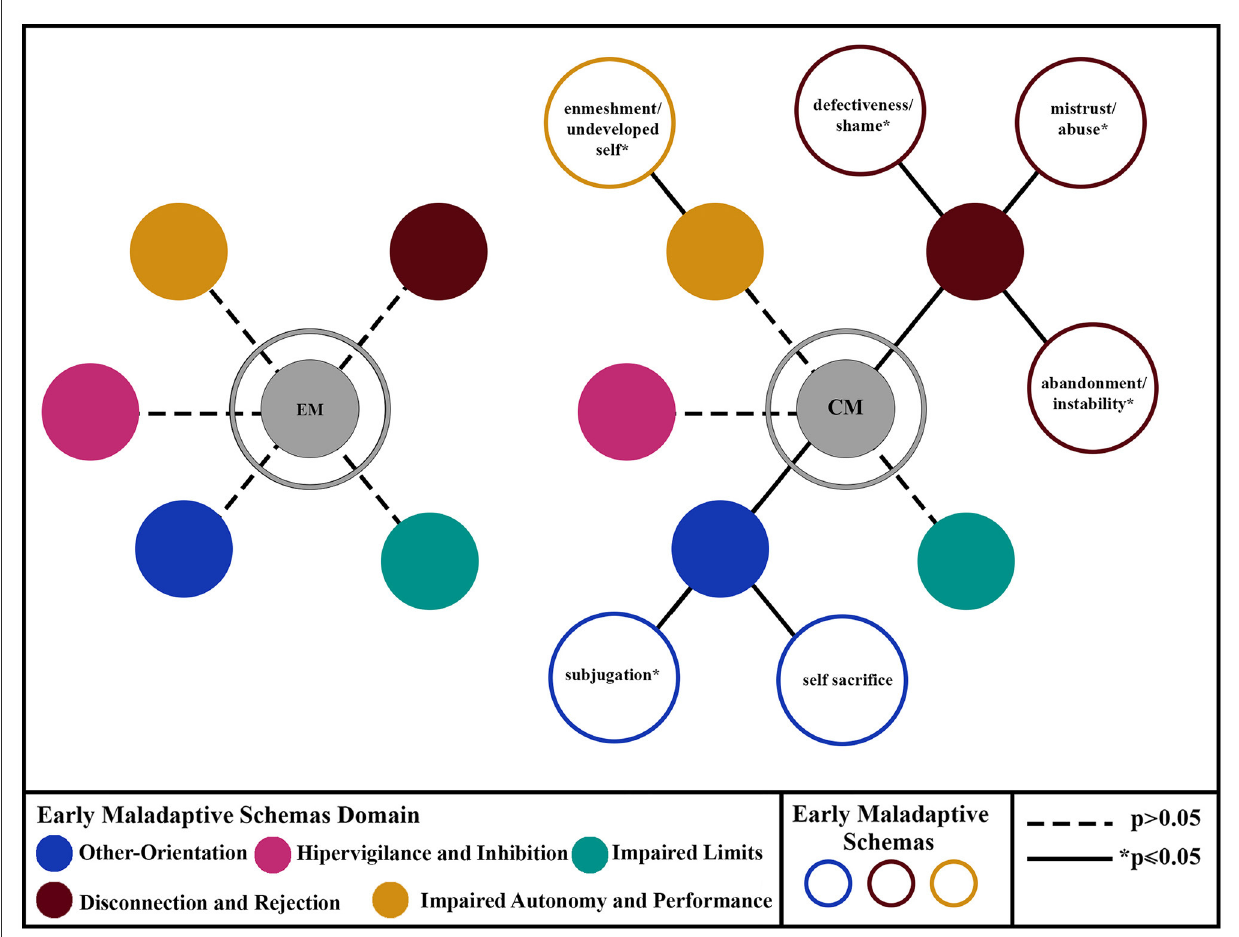
FIGURE2 Illustration showing a summary of the EMSs and EMS domain scores from bivariate comparisons between EM and CM.